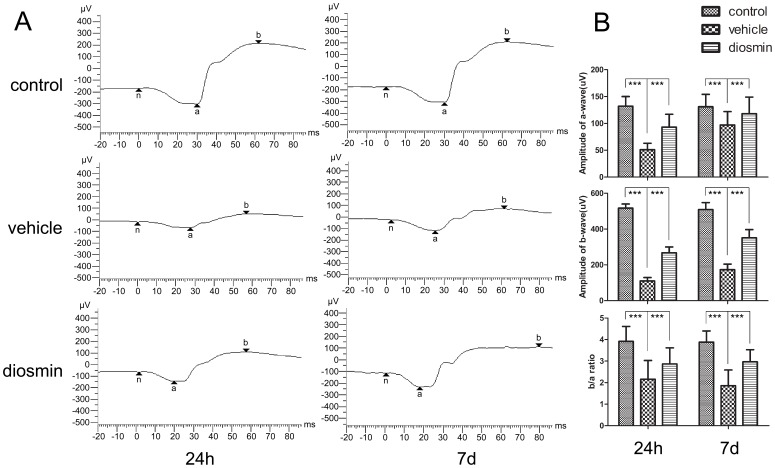
Effect of diosmin on the scotopic a- and b-wave amplitudes as assessed by ERG.(A) Typical ERG records for the three groups 24 hours and 7 days after ischemia. (B) The ERG was recorded for quantitative analysis. The a- and b-wave amplitudes were measured, and the b/a ratio was determined. Data are expressed as the mean±SD (n = 8). ***P<0.001.